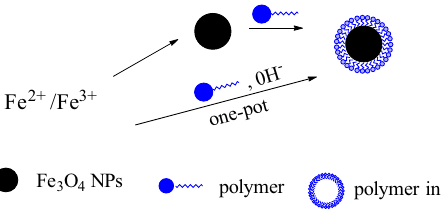
Figure 1: Preparation methods of iron